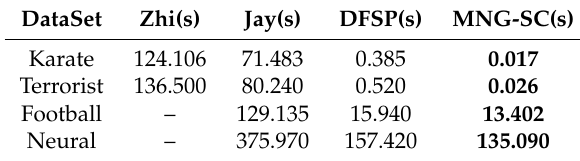
Table 3. The running time comparison of stability calculation algorithms on different